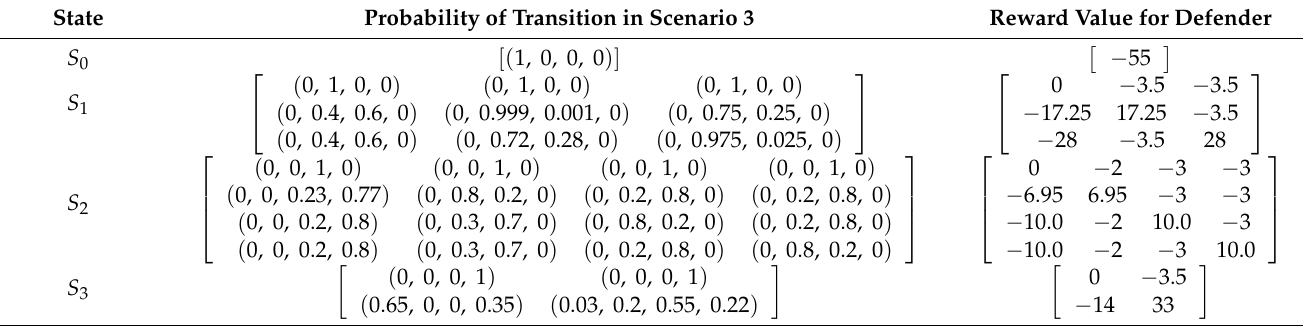
Table A2. Probability matrix of transition and semi-constant reward value with payoff strategy in IoT-enabled Scenario 3.